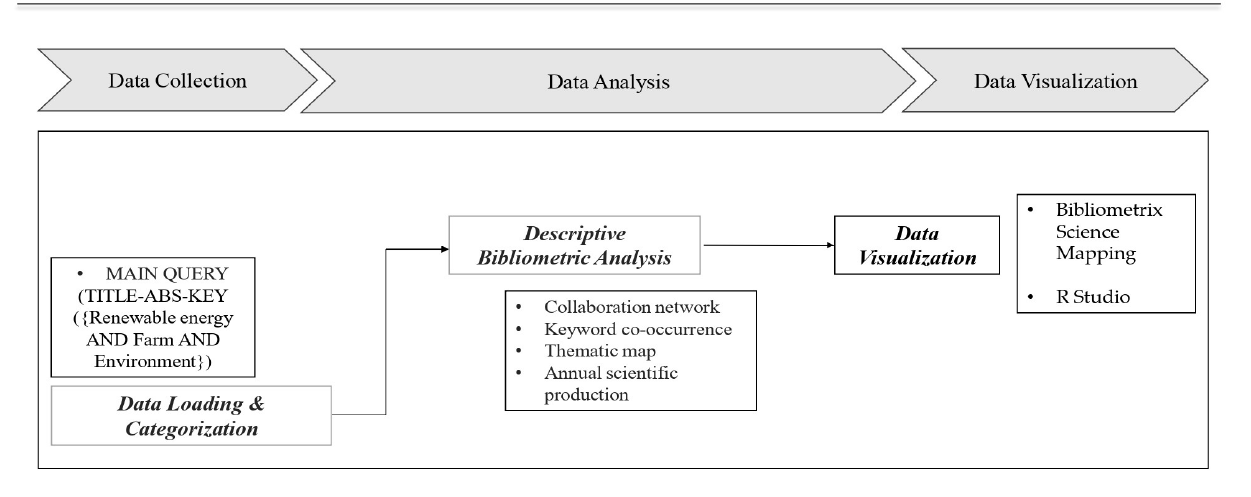
Figure 1. Workflow of the methodology process. Source: Authors' construction.